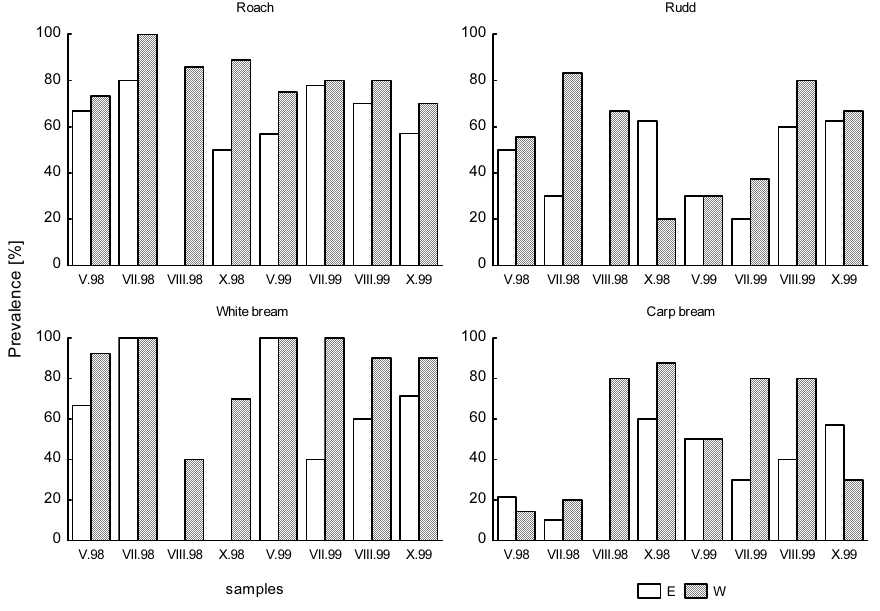
Fig. 2. Prevalence of P. cuticola in fish from eastern (E) and western (W) part of OÊwin